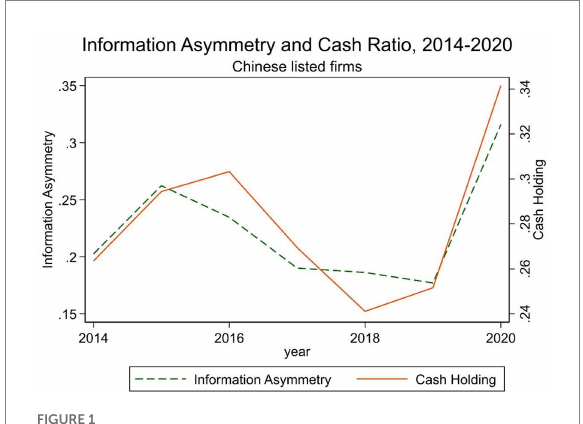
FIGURE 1 Information asymmetry and cash ratio,